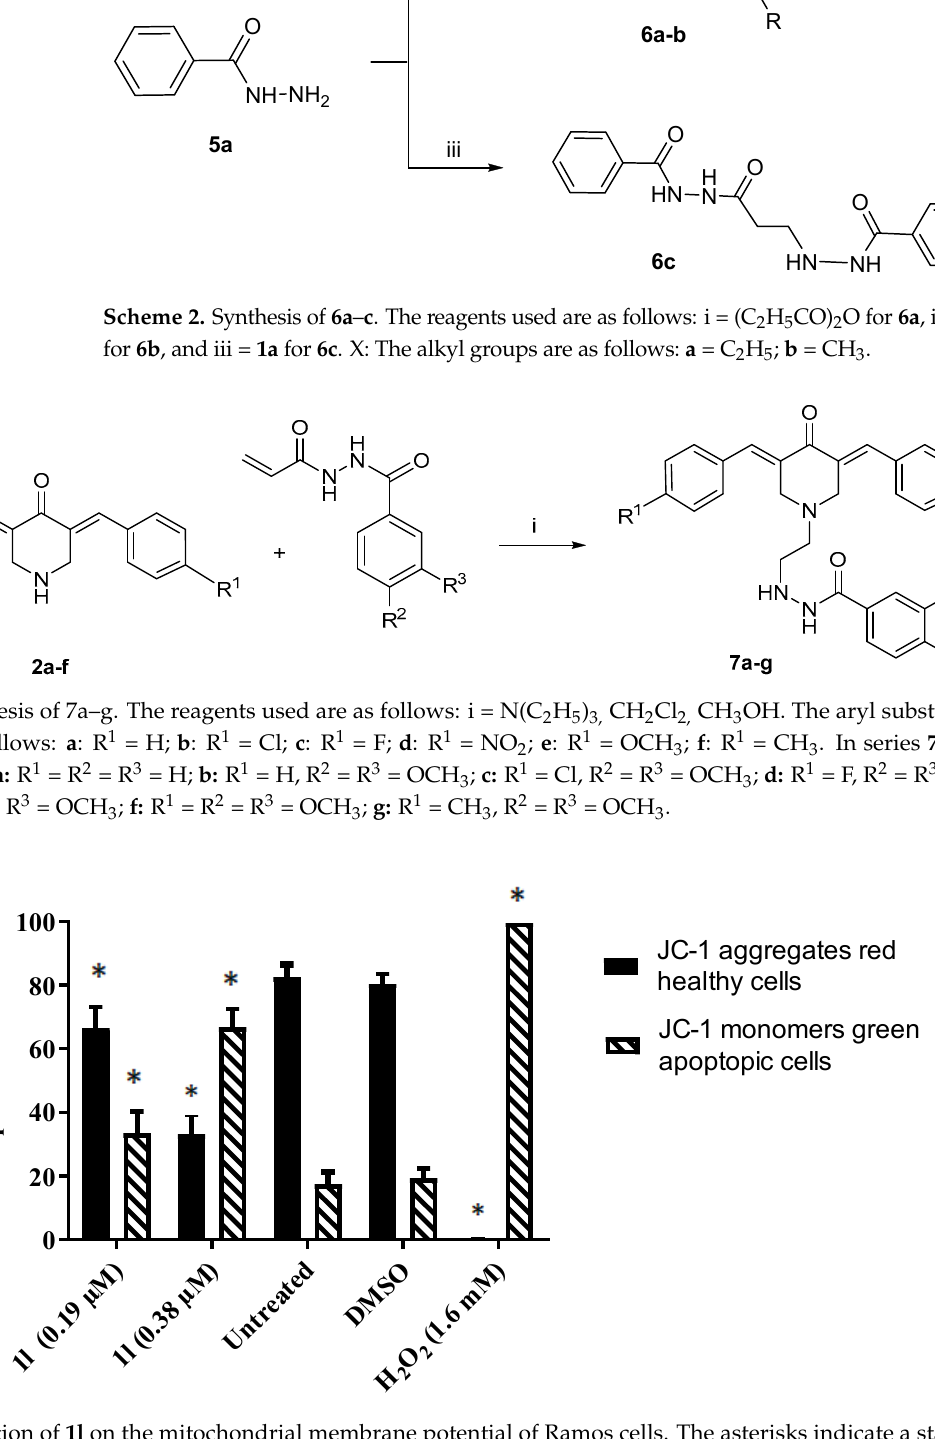
Figure 4. Evaluation of 1m , 7a , e , and g on the mitochondrial membrane potential of HCT 116 cells.